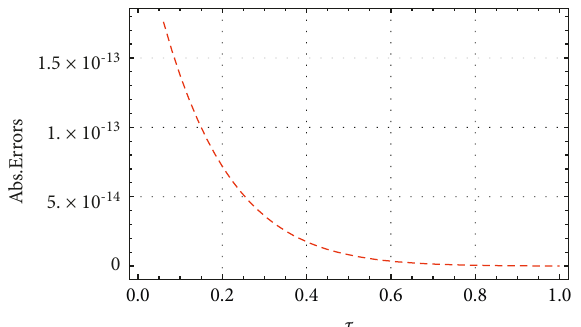
Figure 9: The absolute error for the real part of Example 1.